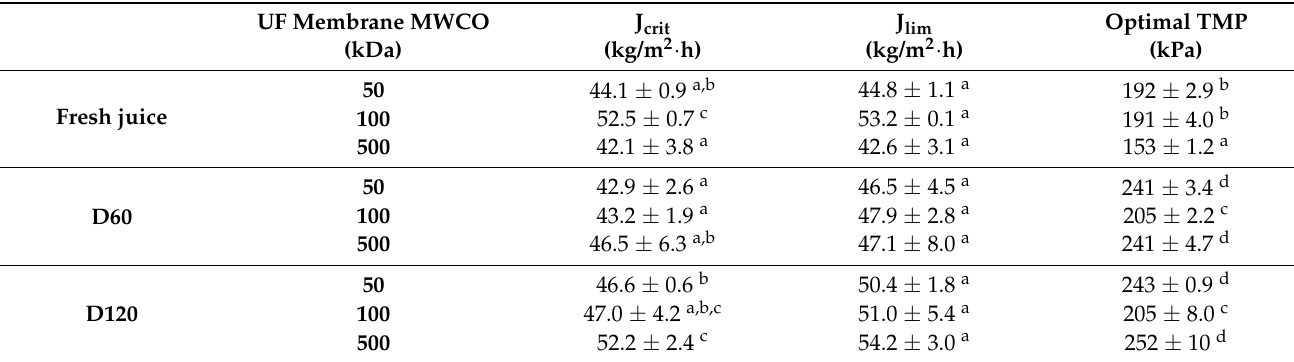
Table 1. Values of optimal TMP, critical flux (Jcrit) and limiting flux (Jlim) during total recirculation of raw and depectinized (D60 and D120) cranberry juices clarified by UF with membrane MWCO of 50, 100 and 500 kDa.